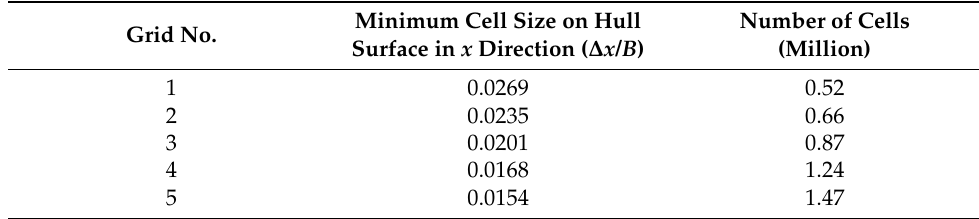
Table 4. Generated girds in the current paper.